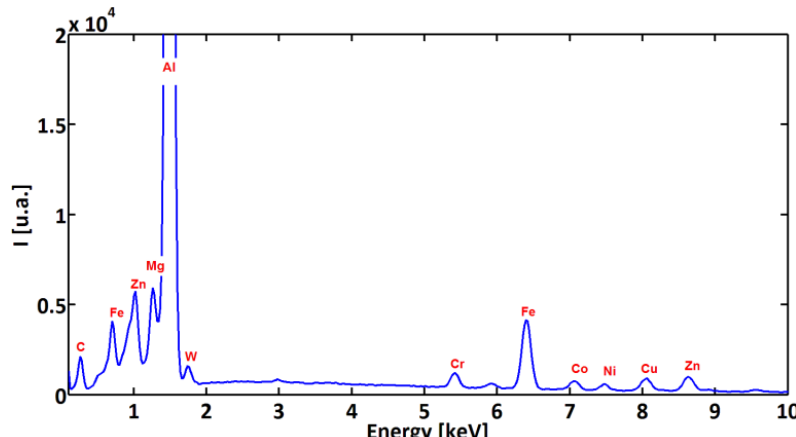
Figure 12. EDS analysis of the hard